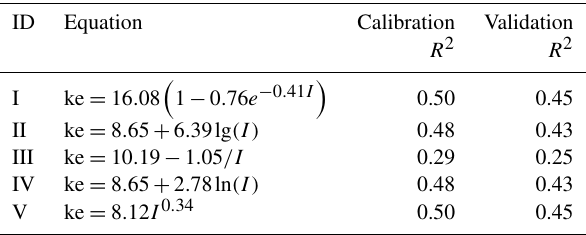
Table 1. Relationship of ke– I at Chilbolton Station